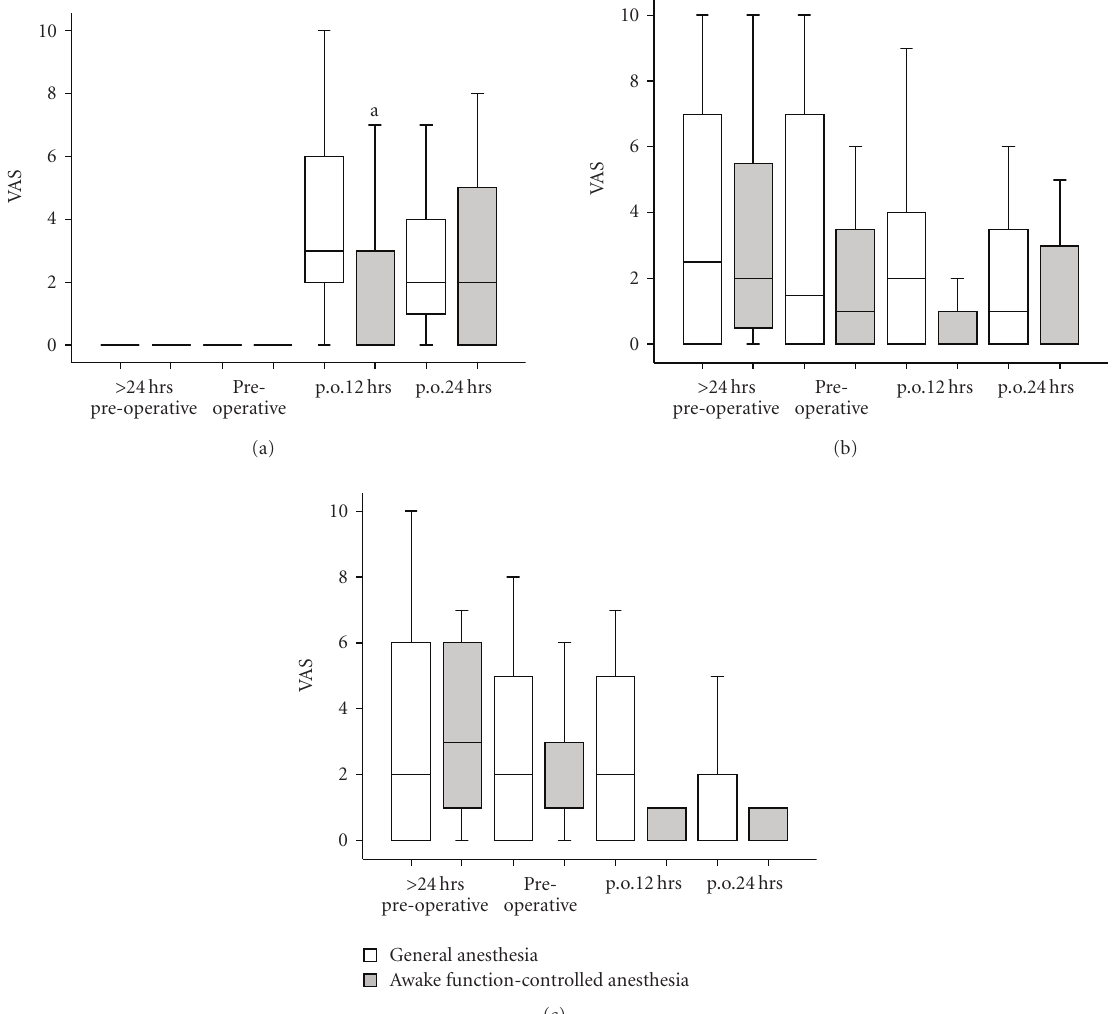
Figure 4: Box plots of pain, anxiety, and stress. (a) Pain. A significant increase in pain is experienced in both experimental groups F(2.290, 80.165) = 24.642, P < . 001. A significant di ff erence F(1, 35) = 7.632, P = . 009 was observed in the awake group compared to the general anesthesia group at “p.o.12 hours” ( a ). (b) Anxiety. A significant decrease in anxiety is experienced in both experimental groups F(1.982, 69.362) = 4.637, P = 0.013 . (c) Stress. A significant decrease in stress is experienced in both experimental groups F(2.426, 84.911) = 7.920, P < .